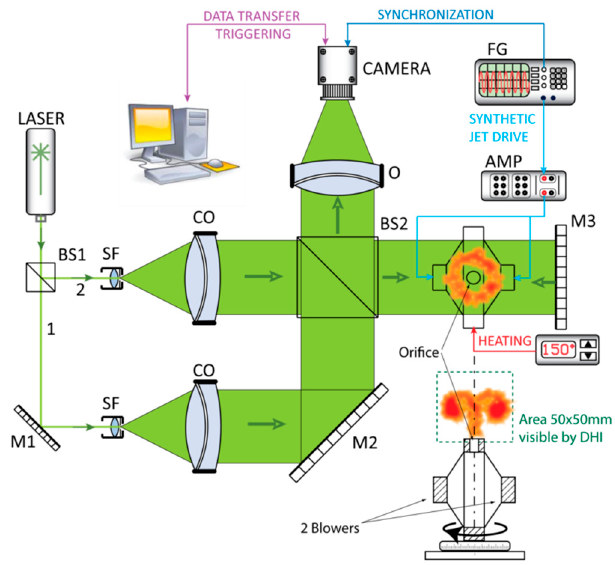
Figure 2. Schematic view of the experiment using a Twyman–Green interferometer with double sensitivity [66]. BS—beam splitter, SF—spatial filter, CO—collimation objective, O—objective, M—mirror, FG—function generator, AMP—amplifier.